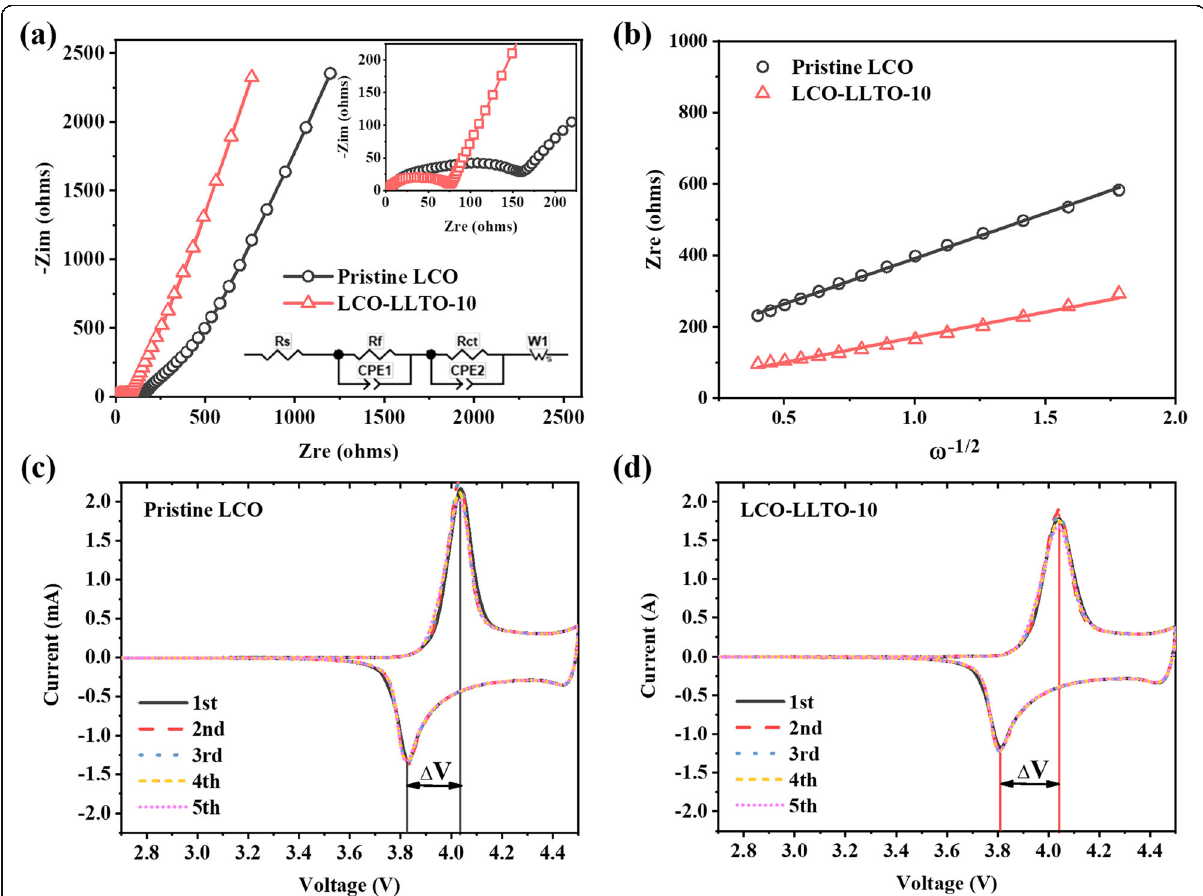
Fig. 3 a Electrochemical impedance spectra of pristine LCO and LCO-LLTO-10 and the equivalent circuit model; b The correlation between Z re and ω − 1/2 of pristine LCO and LCO-LLTO-10; c , d CV profiles of c pristine LCO and d LCO-LLTO-10 at a sweeping rate of 0.05 mV/s between 2.75 and 4.5